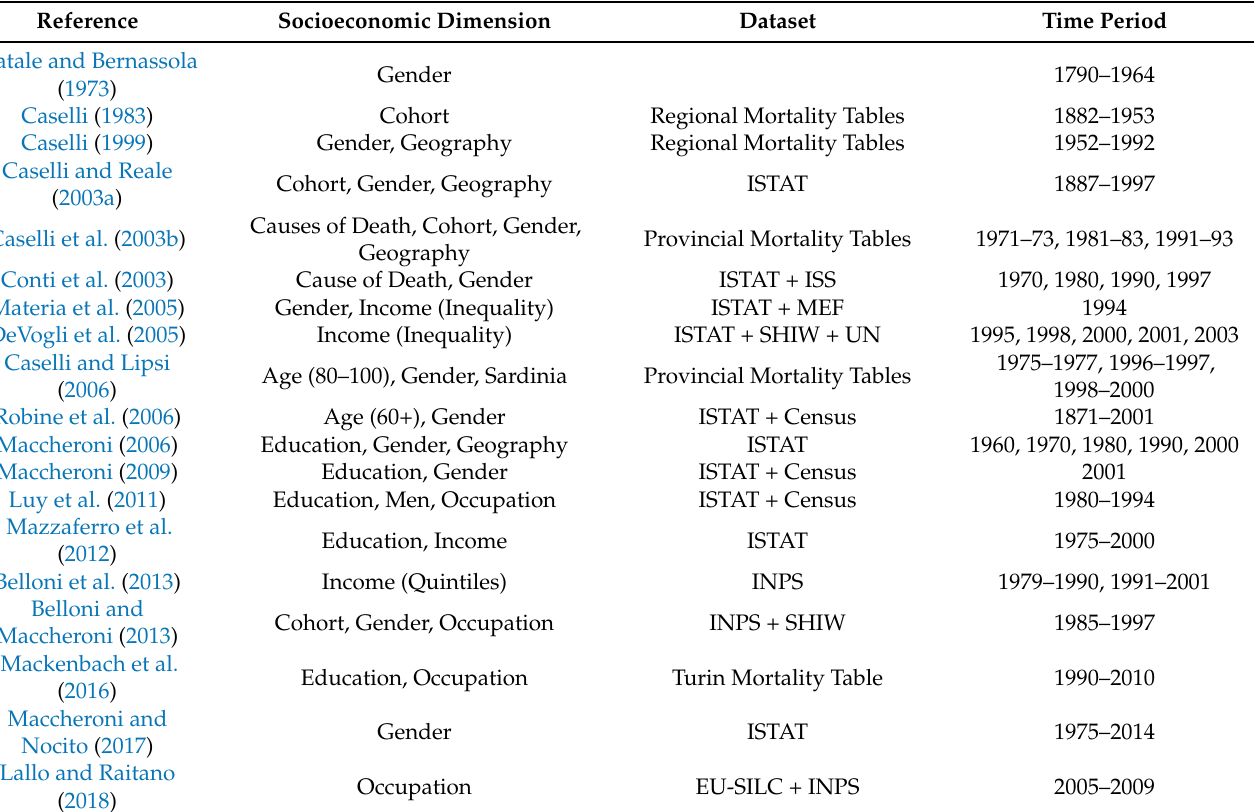
Table 1. Empirical literature on life expectancy heterogeneity in Italy. Datasource: ISTAT (Italian Statistical Institute); ISS (Istituto Superiore di Sanità); MEF (Ministry of Economics and Finance); SHIW (Survey of Household Income and Wealth from the Bank of Italy); UN (United Nations); Census (Italian census data); INPS (Italian social security institute); EU-SILC (European Statistics on Income and Living Conditions)